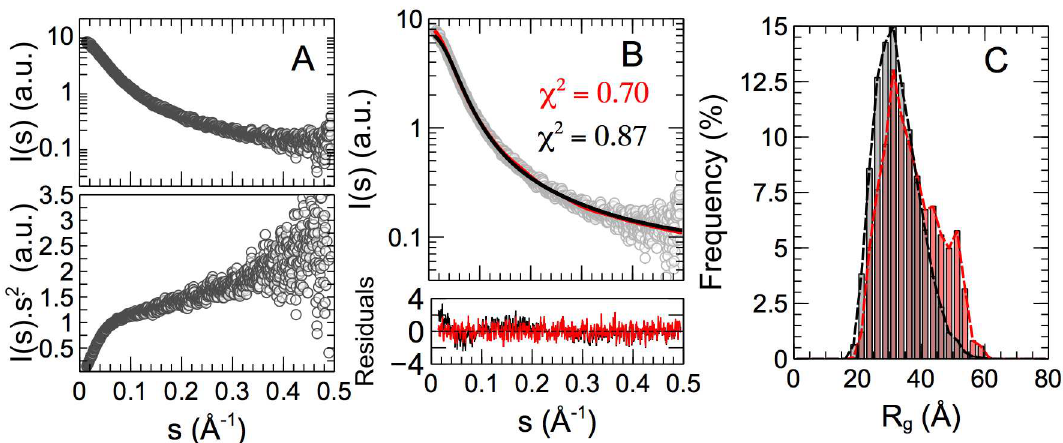
Fig 5. SAXS data and analysis on KISS1. (A) Logarithmic (top) and Kratky (bottom) representations of SAXS intensity versus momentumtransfer s (open circles). (B) Averagedback-calculated curves derived from a statistical random coil ensemble(black line) and EOM selected sub-ensemble (red line). The goodness-of-fit is indicatedby χ 2 values. The bottom panel shows the residualsof the fitting for both conformational ensembles. (C) Distributionof the radius of gyration, Rg, in the randomcoil ensemble(gray-bars)and EOM selectedsub-ensemble, where a shoulderpeak around50 Å containsca. 30% of all conformers.